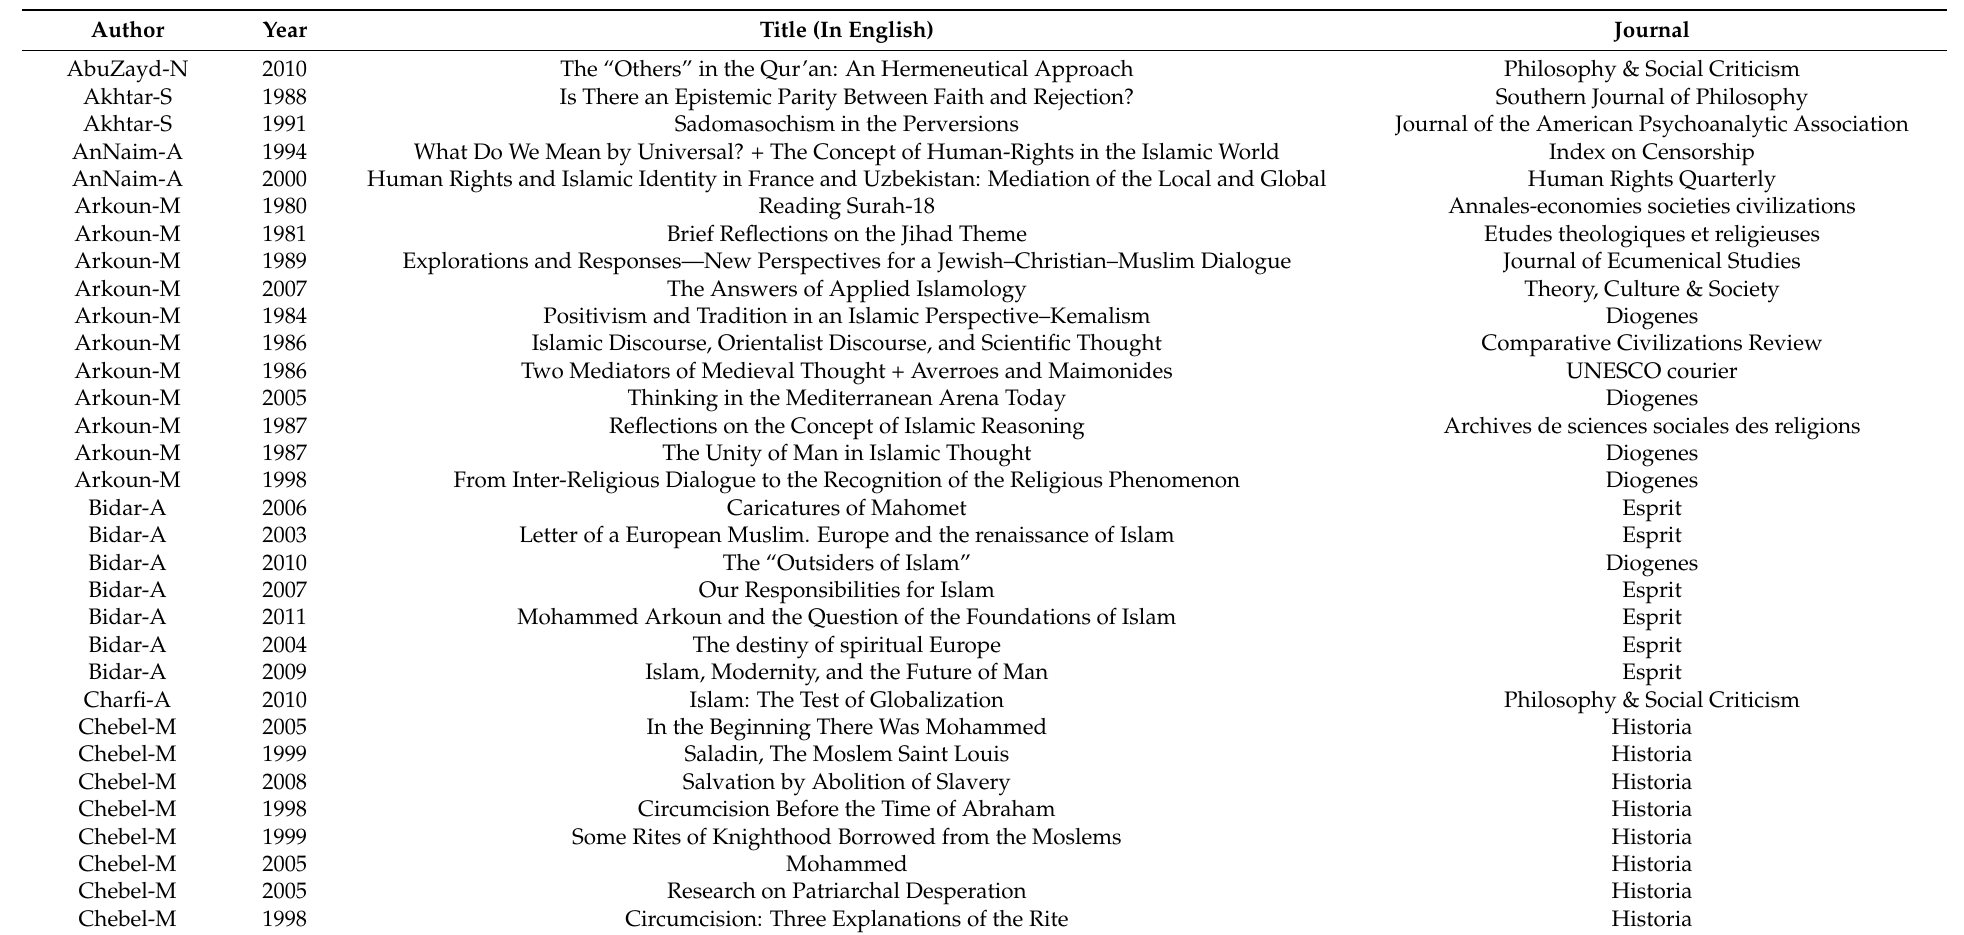
Table A1. List of the Articles Selected for Bibliometrics (All the Titles of the Articles and Journals are Translated to